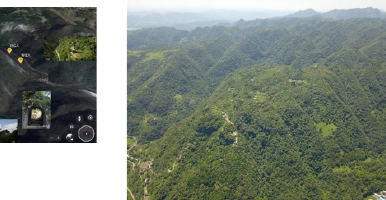
Figure 6 . Topographic map of Longyan Mountain based on Google.